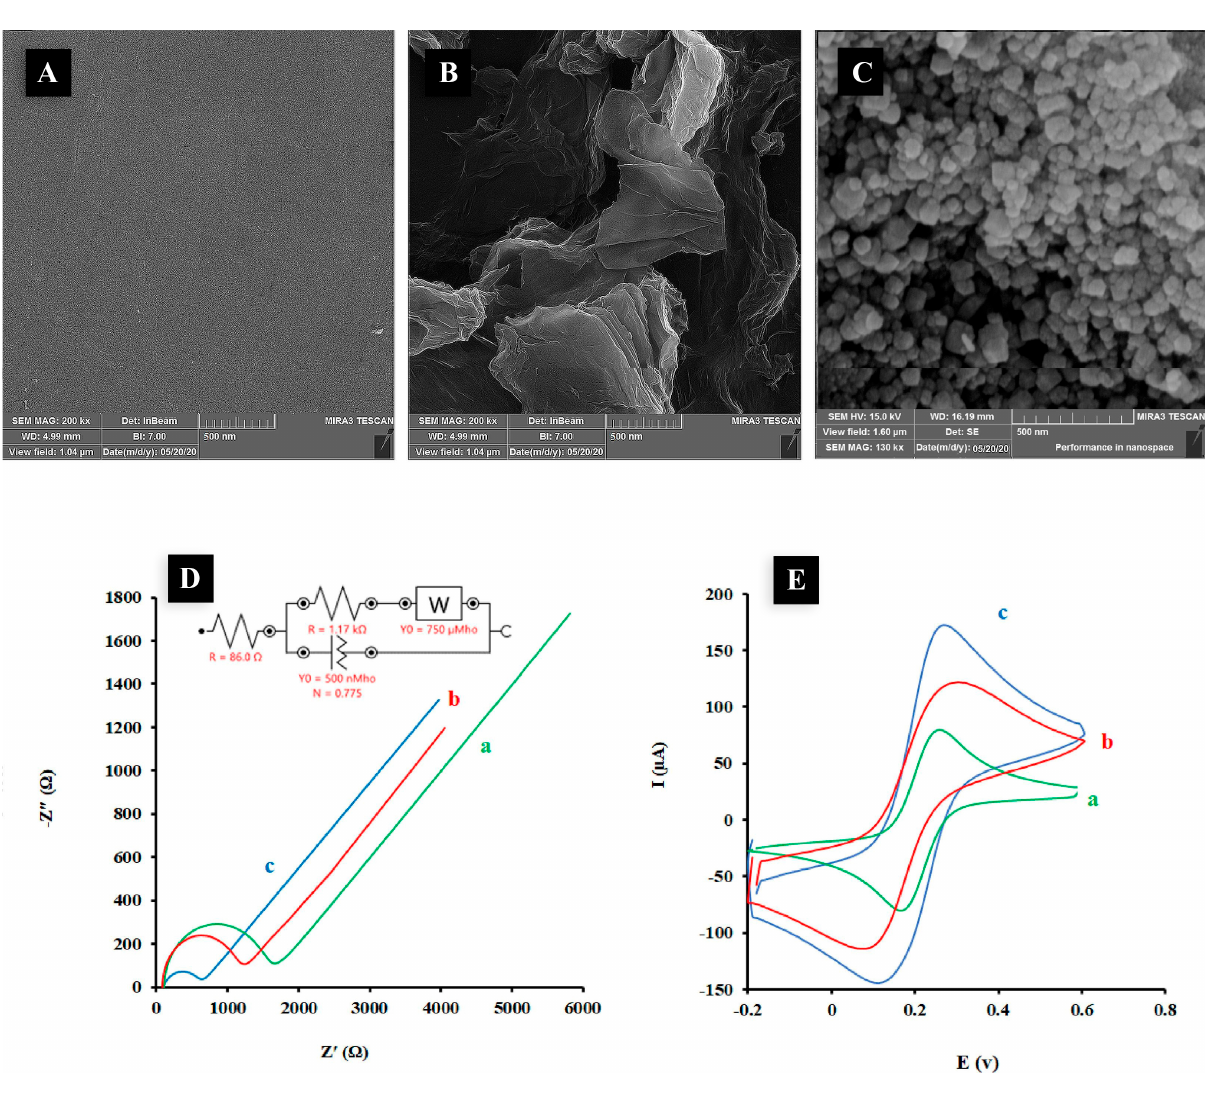
The SEM images of the surface of bare GCE ( A ), ErGO/GCE ( B ), and Fe 3 O 4 @PPy/ErGO/GCE ( C ). The Nyquist plots ( D ) and CVs ( E ) (recorded at scan rate of 50 mV/s) of bare GC (curve a), ErGO/GC (curve b) and Fe 3 O 4 @PPy/ErGO/GC (curve c) in solution containing